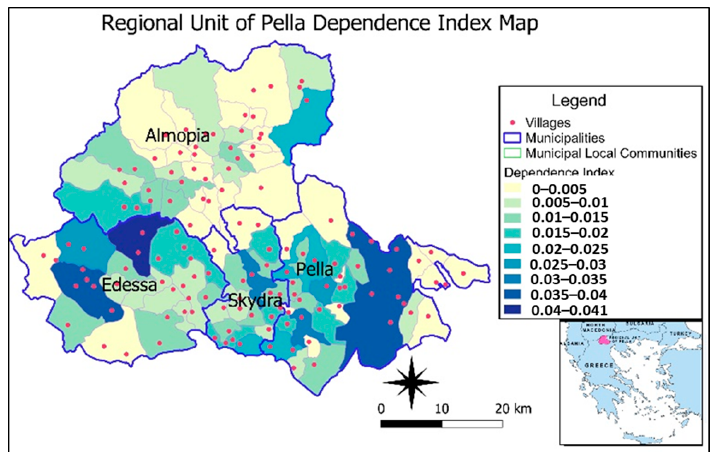
Figure A2. Graded Dependence Map (RDI).